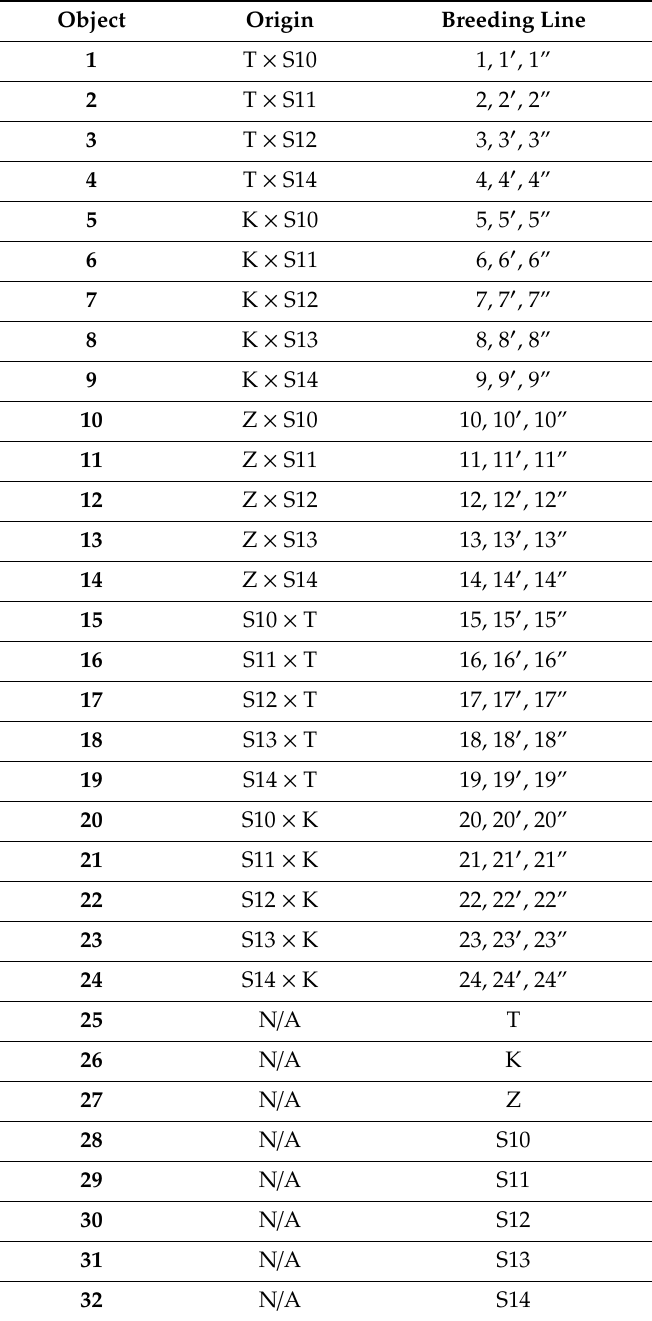
Table 1. Breeding lines and parental forms analyzed in the study. Object Origin Breeding